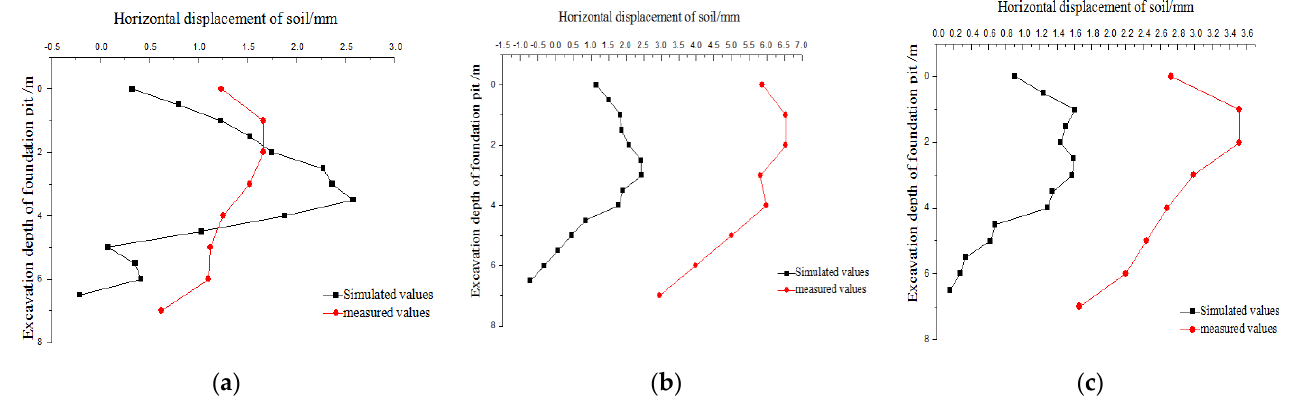
Figure 12. Comparison between simulated and measured values of horizontal displacement of soil. ( a ) Testing set No. 1: soil nailing. ( b ) Testing set No. 4: composite soil nailing. ( c ) Testing set No. 5: composite soil nailing.